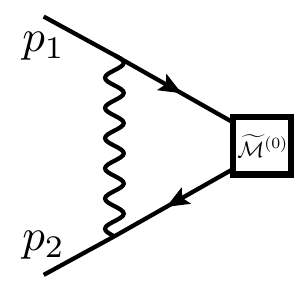
Figure 2. Illustration of F (1) at lowest